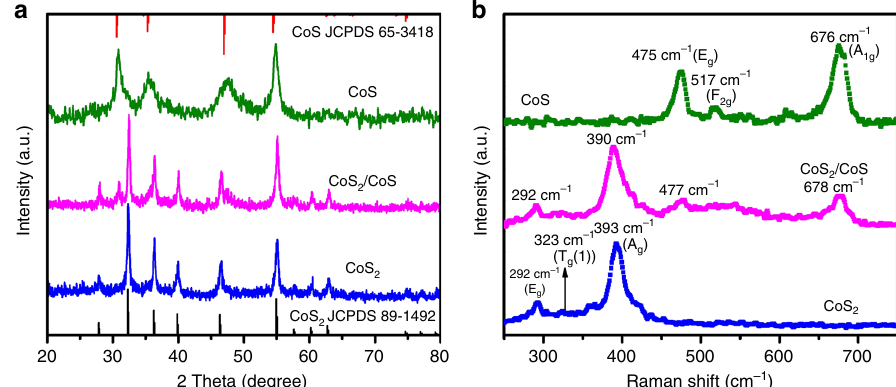
Fig. 1 X-ray powder diffraction (XRD) and Raman characterization. a XRD patterns of the as-prepared cobalt sul fi des compared with the standard